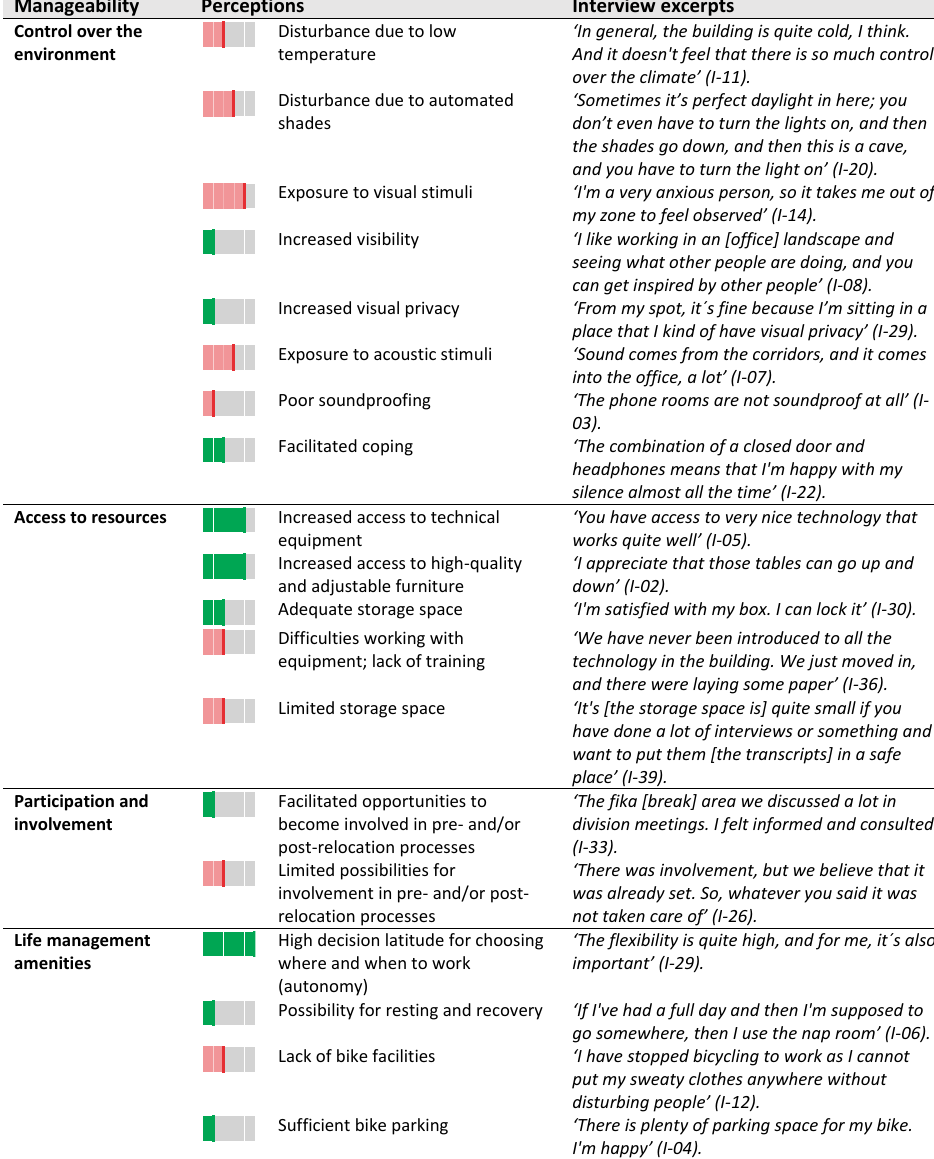
Figure 7. Perceptions of manageability in the office environment as reported in interviews.